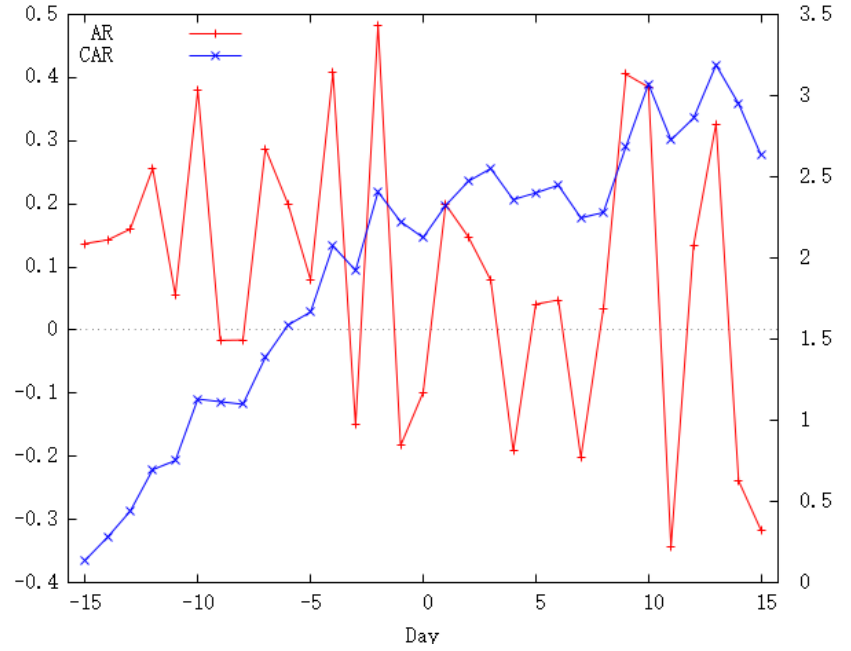
Figure 2. Abnormal returns and cumulative abnormal returns of IC design houses in patent lawsuits.